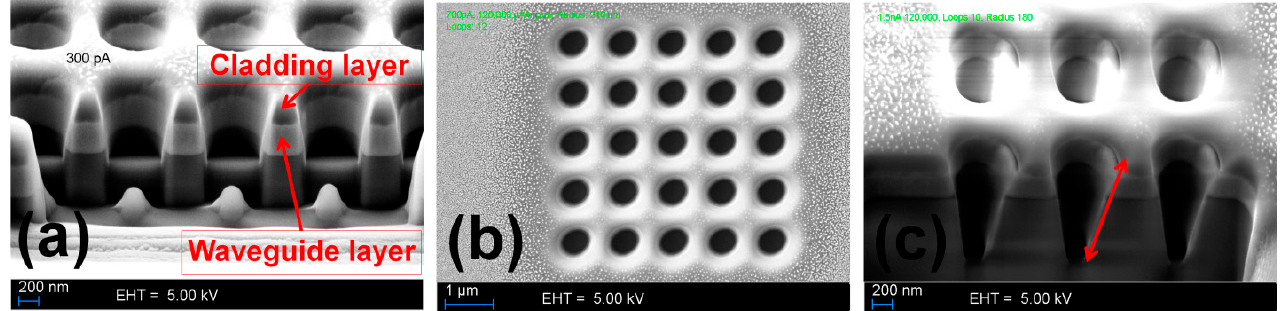
Figure 2. SEM images of fabricated dielectric PhC structures. ( a ) Cross-sectional view of a PhC structure milled with an ion-beam current of 300 pA. Holes reach out equally on both sides of the waveguide layer. ( b ) Top view of a 5 × 5 grid of PhC holes milled with an ion-beam current of 300 pA. ( c ) PhC structures milled with an ion-beam current of 1500 pA. The holes posses a conical structural profile indicated with a red arrow and are approximately 1.5 µm deep.